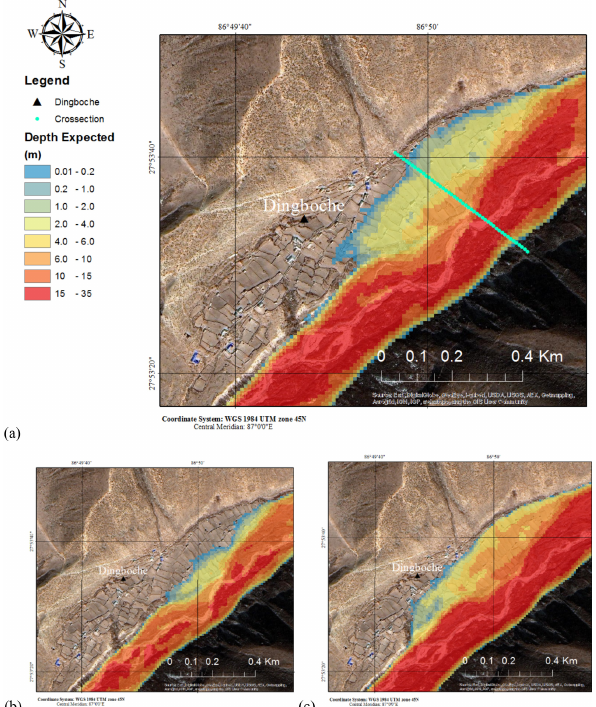
Figure 6. Inundation at Dingboche under current lake conditions: (a) expected inundation and the location of the cross section where the different scenarios are compared, (b) lower bound and (c) upper bound of the possible inundation.